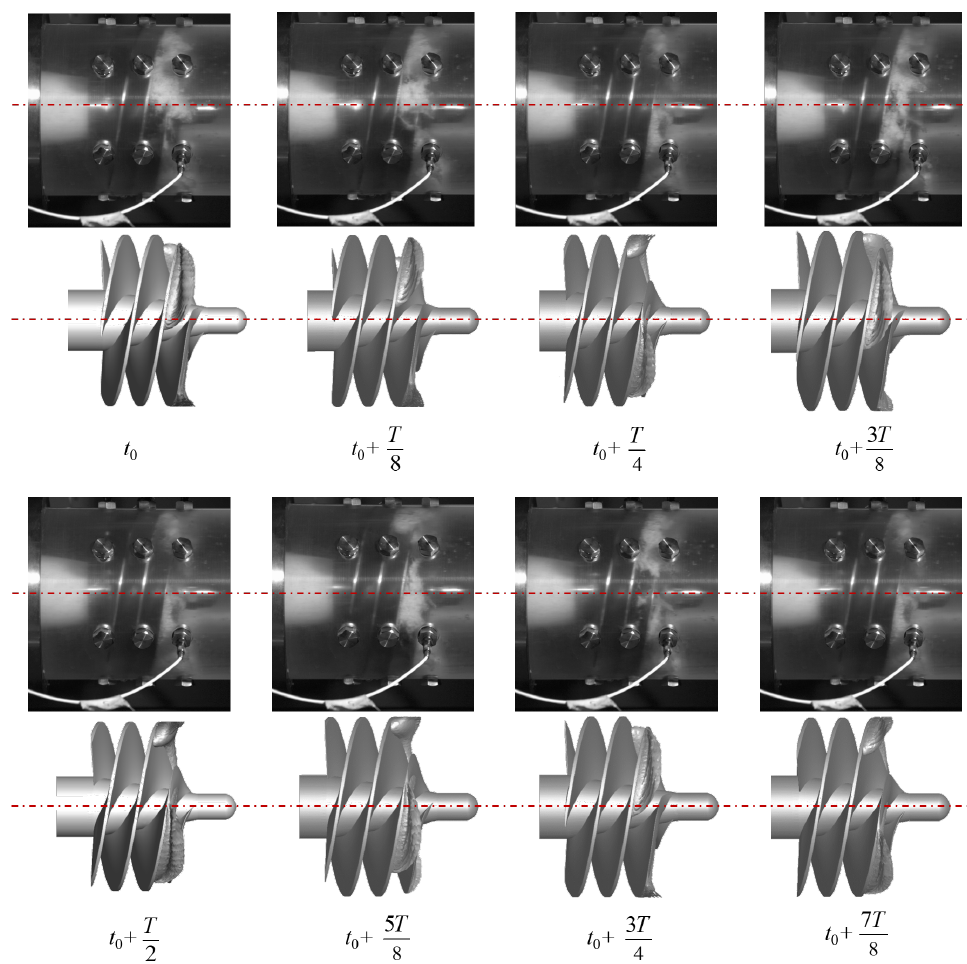
Figure 8. Eight instantaneous captures of the cavity structure in one rotational period ( T ) between experiment ( top ) and simulation ( bottom ) for Model C ( τ = 0.5